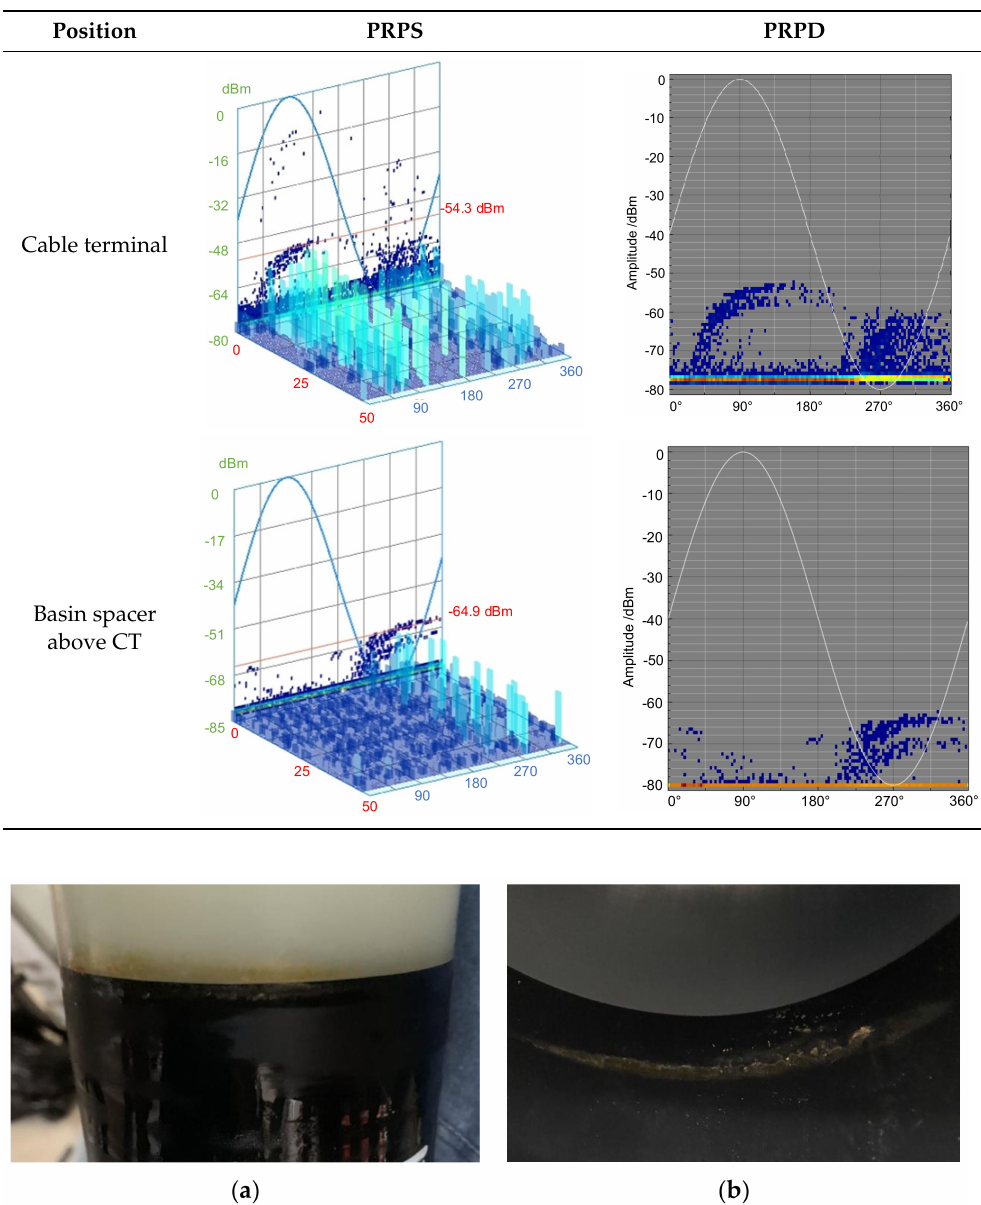
Figure 4. Morphology of the abnormal area of cable terminal. ( a ) Semi-conductive layer, ( b ) inside the stress